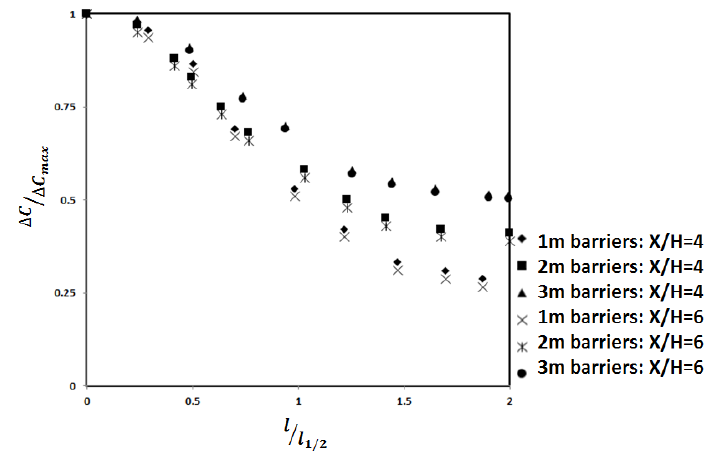
Figure 15. Self-similar pollutant concentration profiles at different downwind locations at different barrier heights.